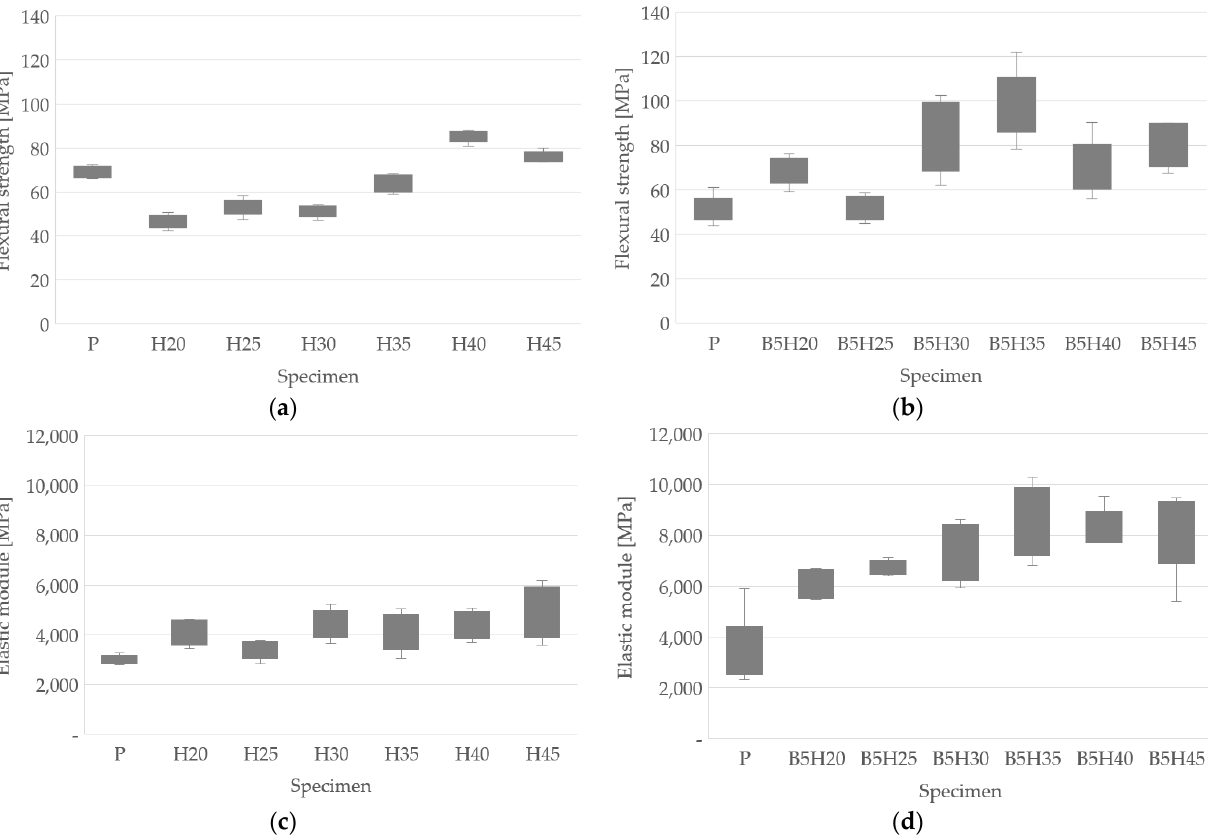
Figure 8. Flexural test results: ( a ) fl exural strength of samples with the addition of fi bers only; ( b ) fl exural strength of samples with the addition of fi bers and bentonite; ( c ) elastic module of samples ( b ) flexural strength of samples with the addition of fibers and bentonite; ( c ) elastic module of with the addition of fi bers only; ( d ) elastic module of samples with the addition of fi bers and ben- samples with the addition of fibers only; ( d ) elastic module of samples with the addition of fibers tonite. and